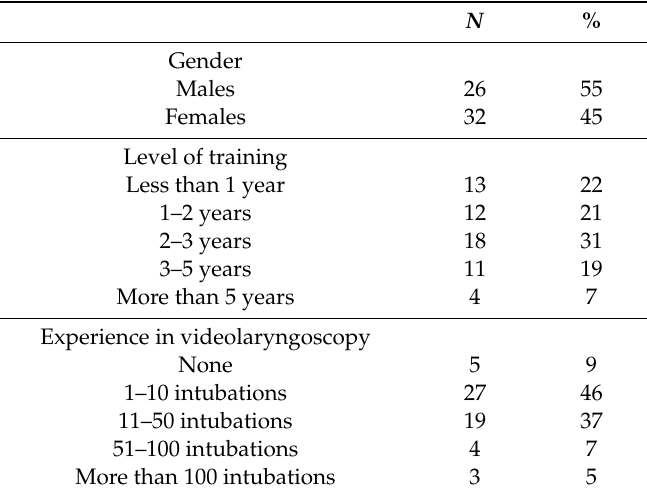
Table 1. Demographic data of the participants.